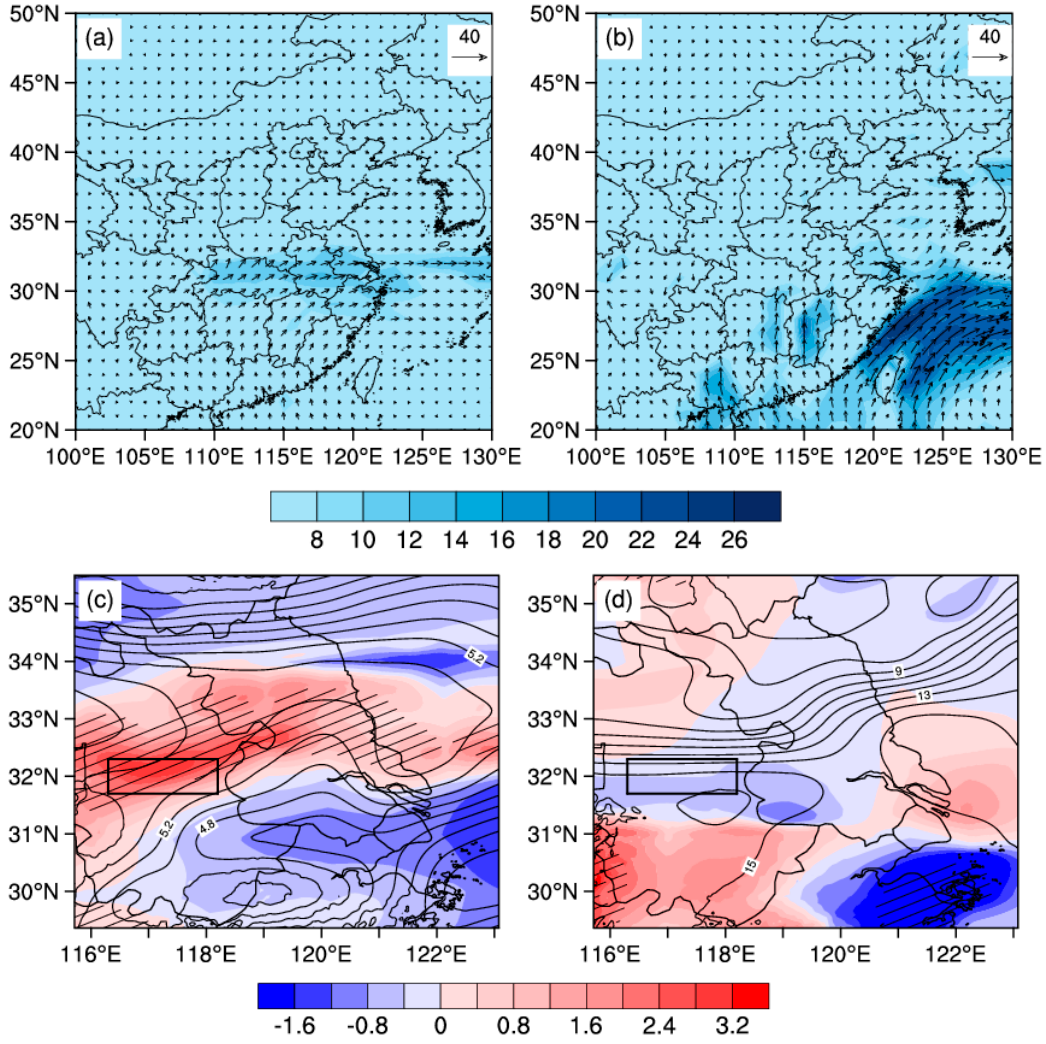
Figure 4. 12 July 2014, 0000 UTC results. ( a ) 500-hPa water vapor flux (vectors and shaded, unit: g/(s · cm · hPa)), ( b ) 850-hPa water vapor flux, ( c ) sensitivity of forecast variable R with respect to a 500-hPa water-vapor mixing ratio (shaded, unit: kg/kg, the dashed area indicates that the sensitivity passed a 0.05-level significance test) and a 500-hPa water-vapor mixing ratio (contoured, unit: kg/kg), and ( d ) sensitivity of forecast variable R with respect to an 850-hPa water-vapor mixing ratio and 850-hPa water-vapor mixing ratio. The black box indicates the response region.